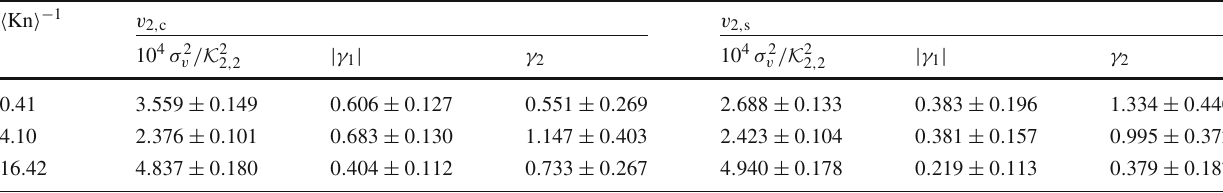
Table 11 Moments of the conditional probability distributions p v | ε (v 2 , c / s | ε 2 , c / s ) of the final-state flow harmonics computed for 10 4 events at b = 9 fm. The variance σ 2 v is divided by the square K